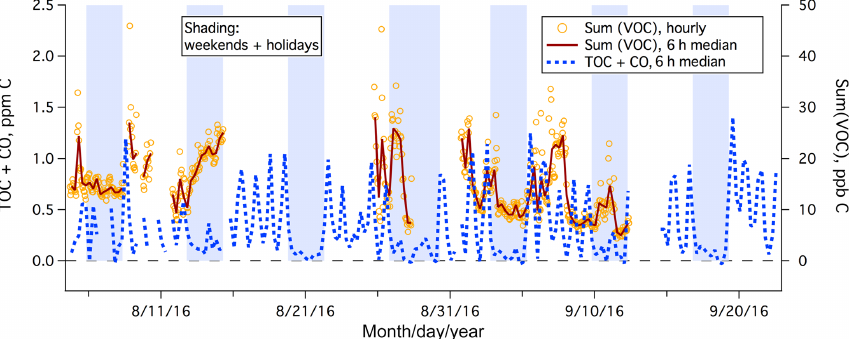
Figure 8. Time series of TOC + CO and Sum(VOC) from the rooftop of Plymouth Marine Laboratory. Sum(VOC) is shown as hourly mean and 6h median, while for clarity TOC + CO is shown as the 6h median